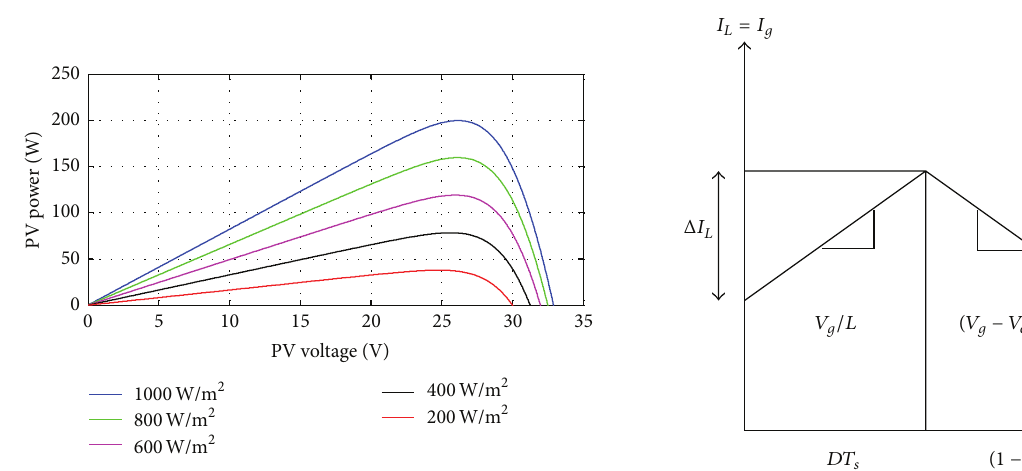
Figure 2: I-V output characteristic with different irradiance.